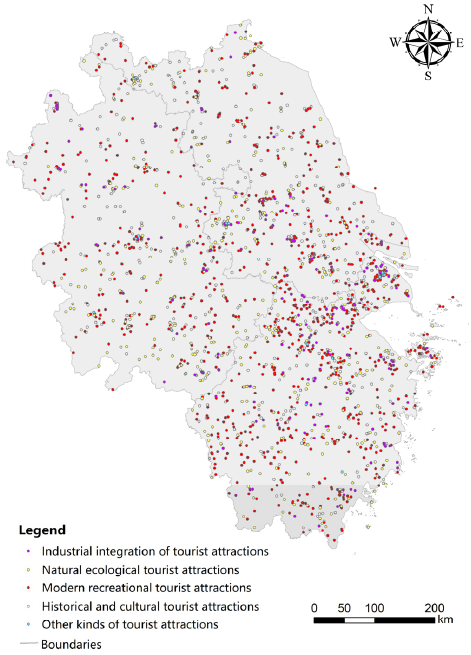
Figure 1. Spatial layout of different types of tourist attractions.